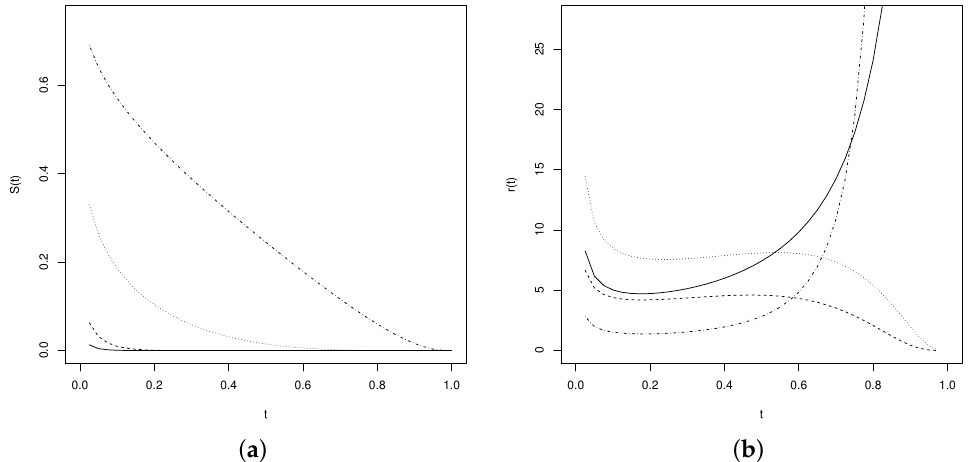
Figure 2. Survival and hazard functions for µ = 0.25, σ = 1.75 and values of ( λ , α ) = ( 1.75,0.5 ) (dotted–dashed line), ( 1.75,1.5 ) (dotted line), ( 4.75,3.5 ) (dashed line) and ( 4.75,5.5 ) (solid line) ( a ) S ( t ) and ( b ) r ( t )